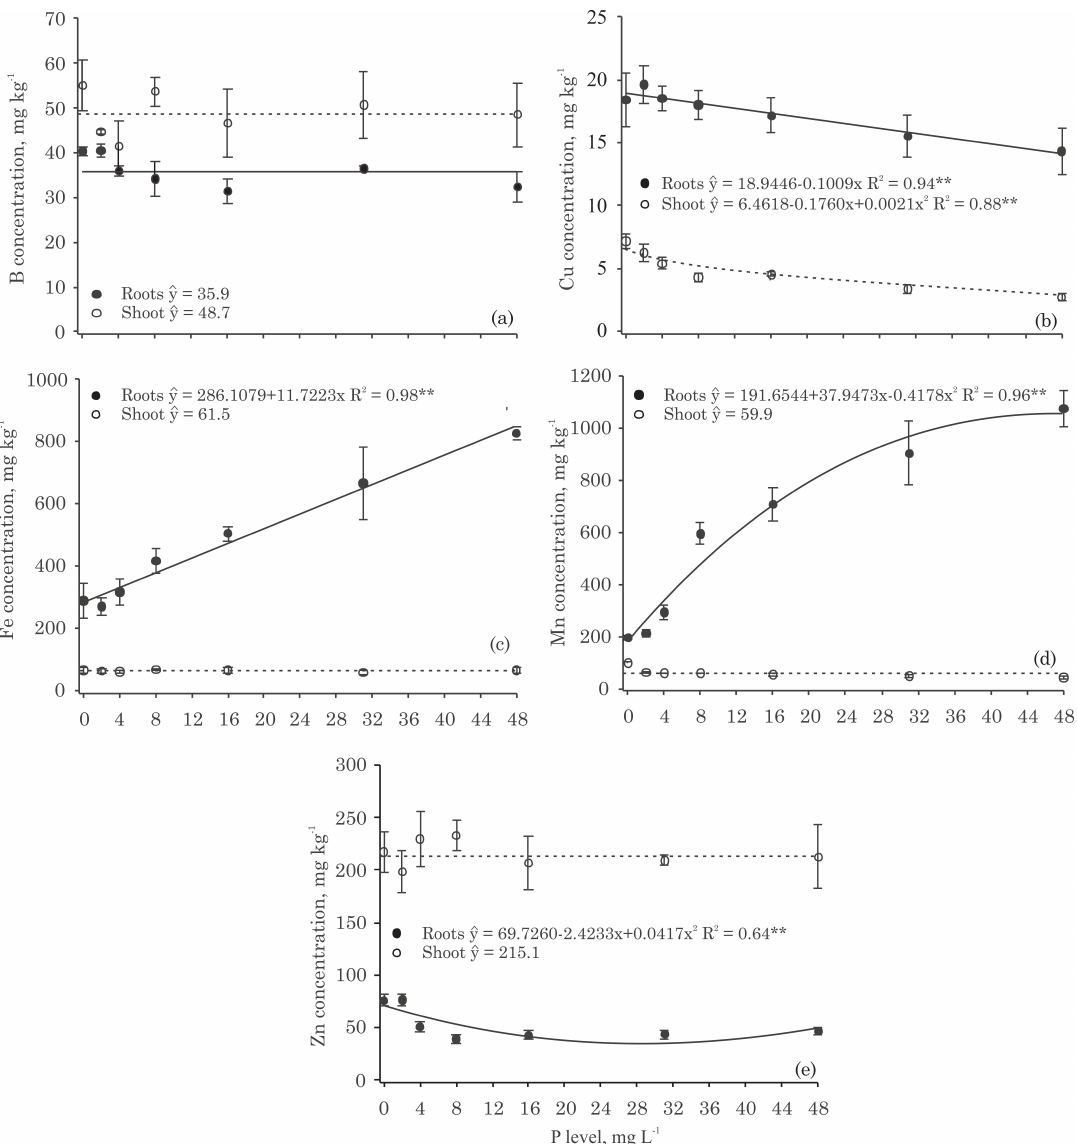
Figure 4. Boron (a), copper (b), iron (c), manganese (d), and zinc (e) concentrations in roots and shoots biomass of potato plants, cv. Ágata, as affected by P levels in the nutrient solution. * p > 0.05 and ** p > 0.01. Vertical bars represent the standard